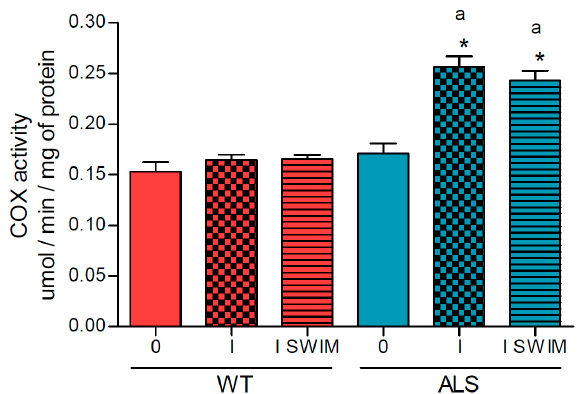
Figure 4. Cytochrome c oxidase activity in skeletal muscle of ALS and WT mice. The activity of COX was measured in skeletal muscle homogenates. There were significant differences between the groups: * p = 0.0001 vs. ALS 0; a p = 0.0001 between the indicated ALS and corresponding WT groups. The data are presented as the means ± SEM ( n = 8 in each group).